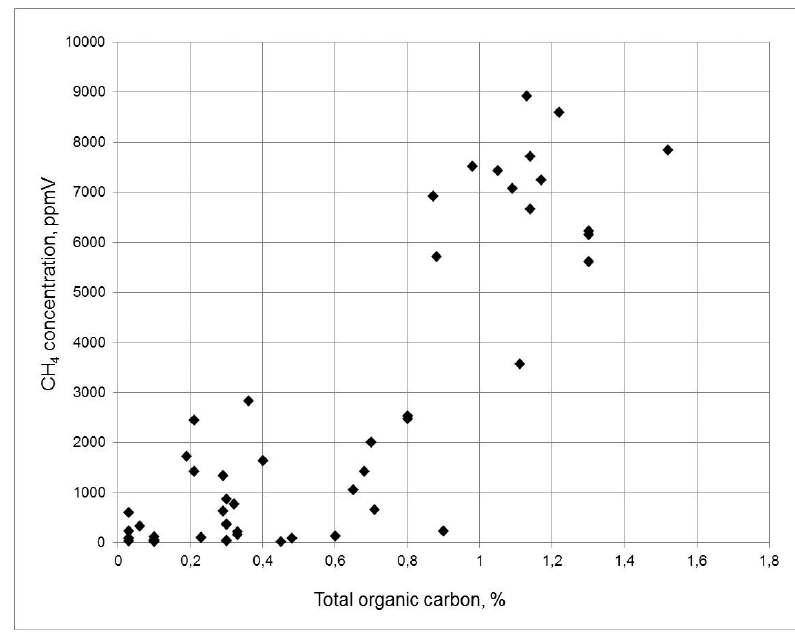
Figure 3. Concentration of methane in frozen sediments versus total organic carbon content at the Marre-Sale site.